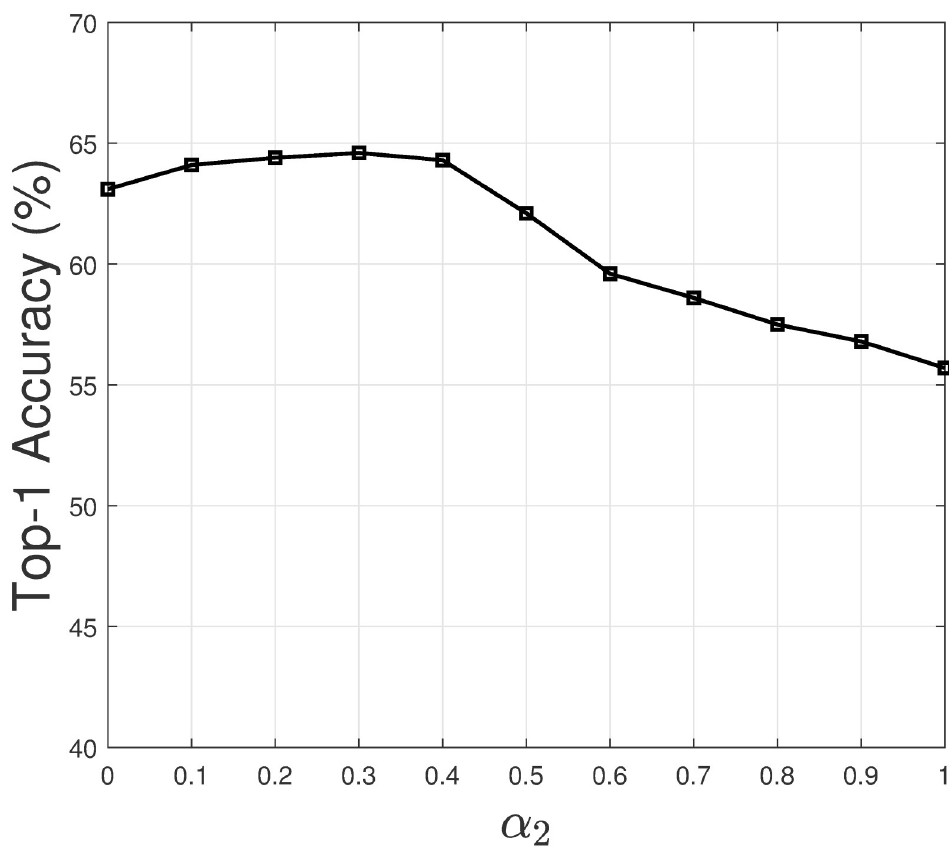
Fig 9. Top-1 accuracy when α 2